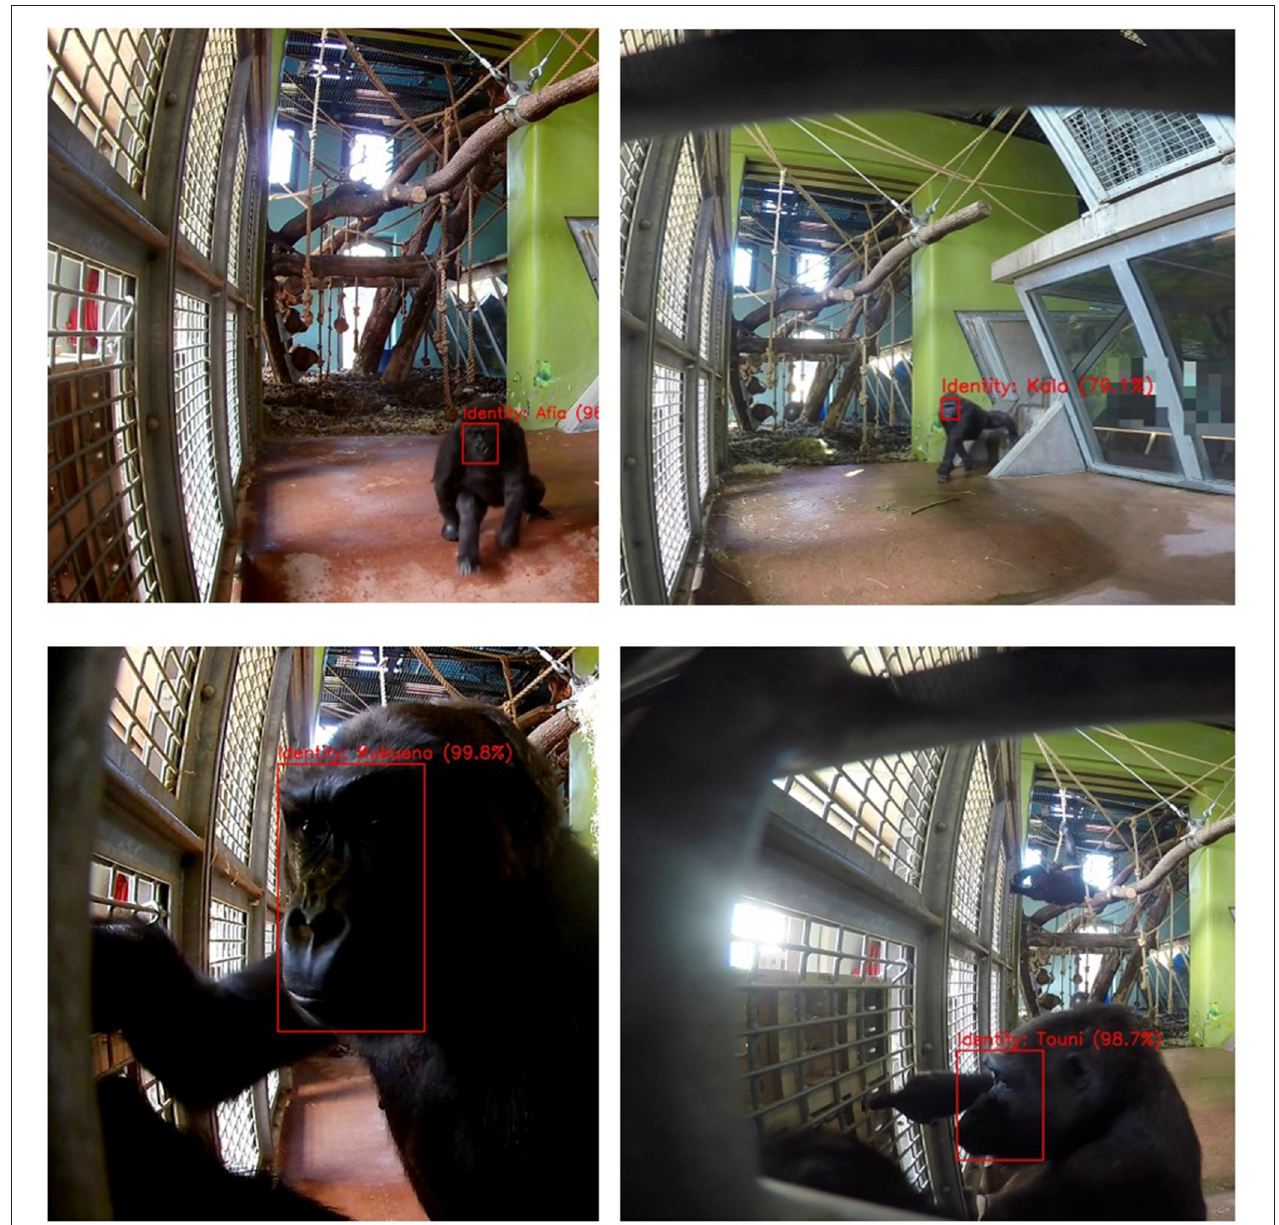
FIGURE 5 | Single frame detection. The figure shows a collection of images of gorillas interacting with the Gorilla Game Lab device (on the left of each image) after processing by the facial recognition model. The red boxes represent facial localization predictions. The gorilla identities are also predicted by the model with the prediction confidence indicated as a percentage in